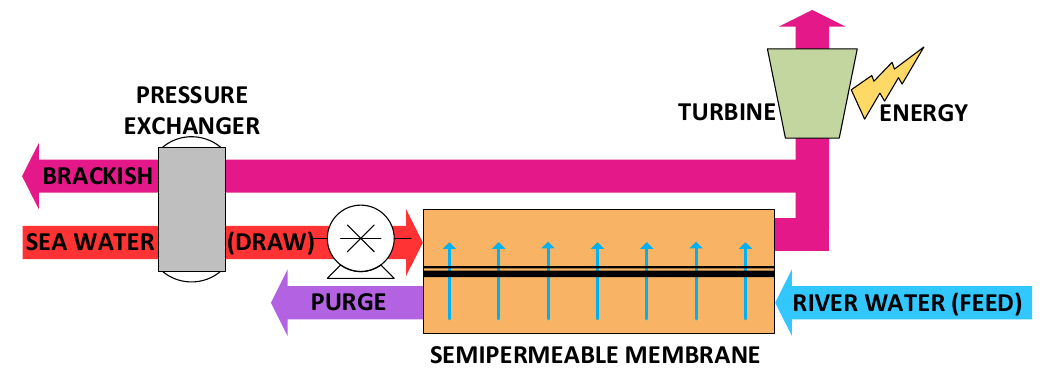
Figure 1. Block diagram of a standard PRO process.